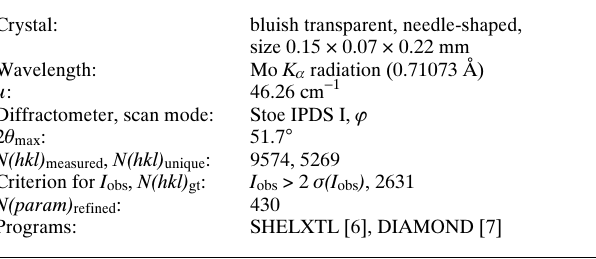
Table 1. Data collection and handling.